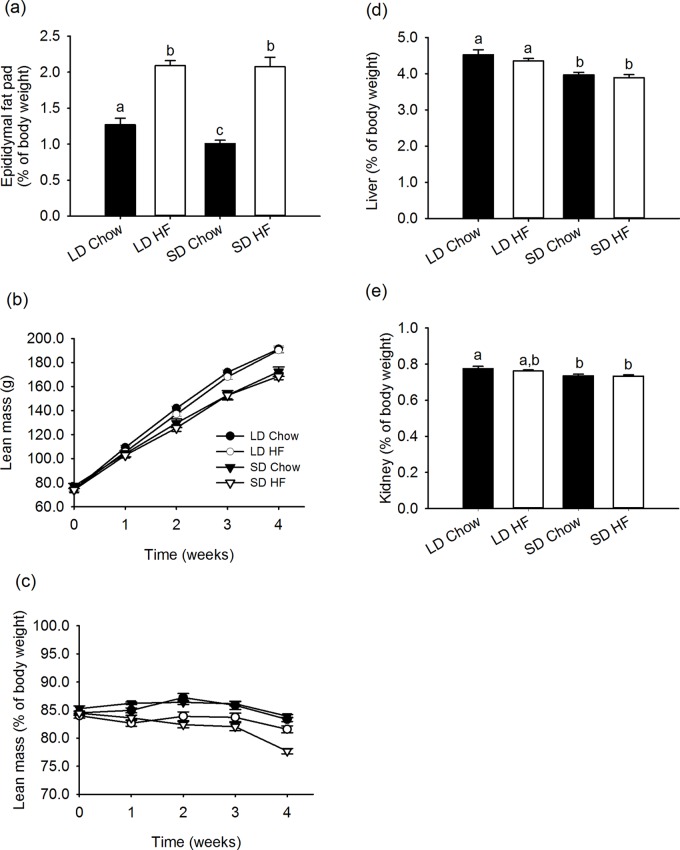
Effect of photoperiod and high fat diet (HFD) on epididymal fat, lean mass and liver and kidney weight of juvenile F344 rats over, or after, 4 weeks of treatment.(a) Epididymal fat pad mass as a percentage of body weight, was greater in LD than SD chow fed rats (p = 0.048). The fat pads masses were significantly greater with HFD feeding than chow in both photoperiods (p<0.001), but there was no effect of photoperiod with HFD feeding. (b) Absolute lean mass was higher in LD than SD rats fed either chow or HFD. The lean masses were not changed by HFD feeding. (c) Lean mass as a percentage of body weight was not significantly different between LD and SD chow fed rats. The lean masses of HFD fed rats were lower than those of the chow fed rats with the SD HFD fed rats being significantly leaner than the LD HFD fed rats (p<0.001). (d) Liver mass was lower in SD than LD chow and HFD fed rats (both p<0.05). The HFD did not impact on the liver masses in either photoperiod. (e) Kidney mass was also lower in both SD chow and HFD fed rats than chow fed LD (P<0.05).